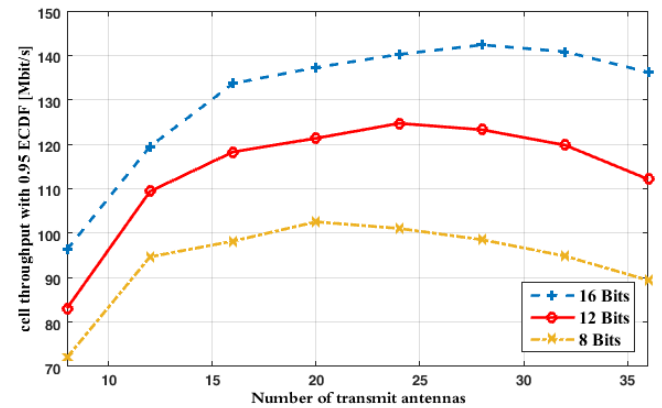
Figure 4. The considered system with CAS, where the UCIC strategy is applied to the system and different numbers of transmit antennas and feedback bits are utilized.